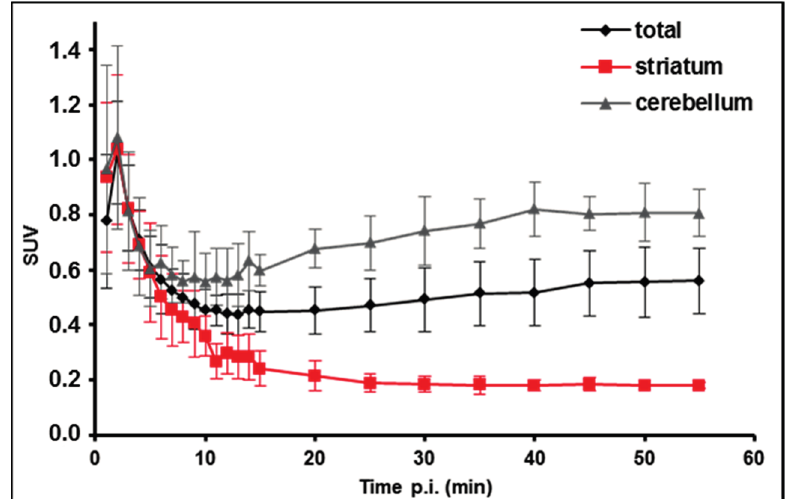
Figure 8. Averaged time-activity curves of [ 18 F] TA3 in CD-1 mice ( n = 4) with standard uptake values (SUV) in whole brain (total), striatum, and